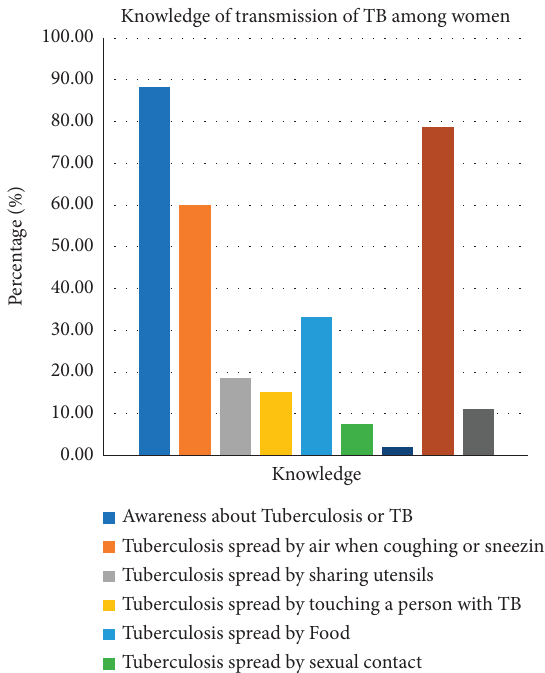
Figure 1: Knowledge of transmission of TB among women ( N �